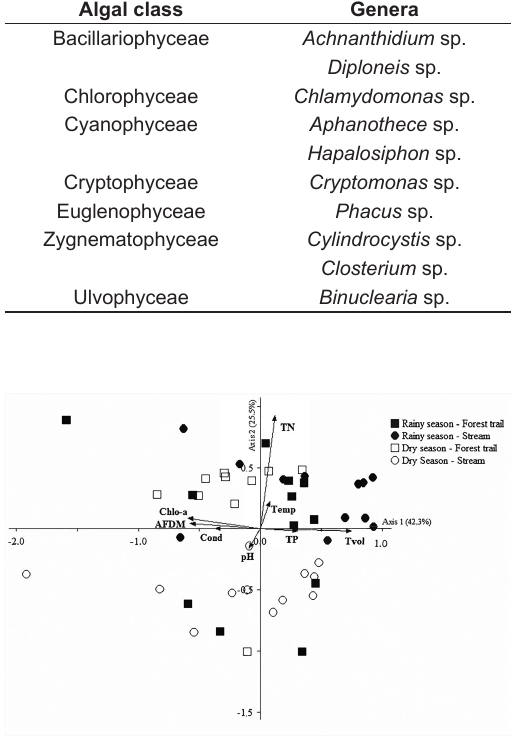
Figure 4. PCA of abiotic and biotic variables in the phytotelmata of Nidularium longiflorum at sampling sites near forest trail and stream in rainy and dry